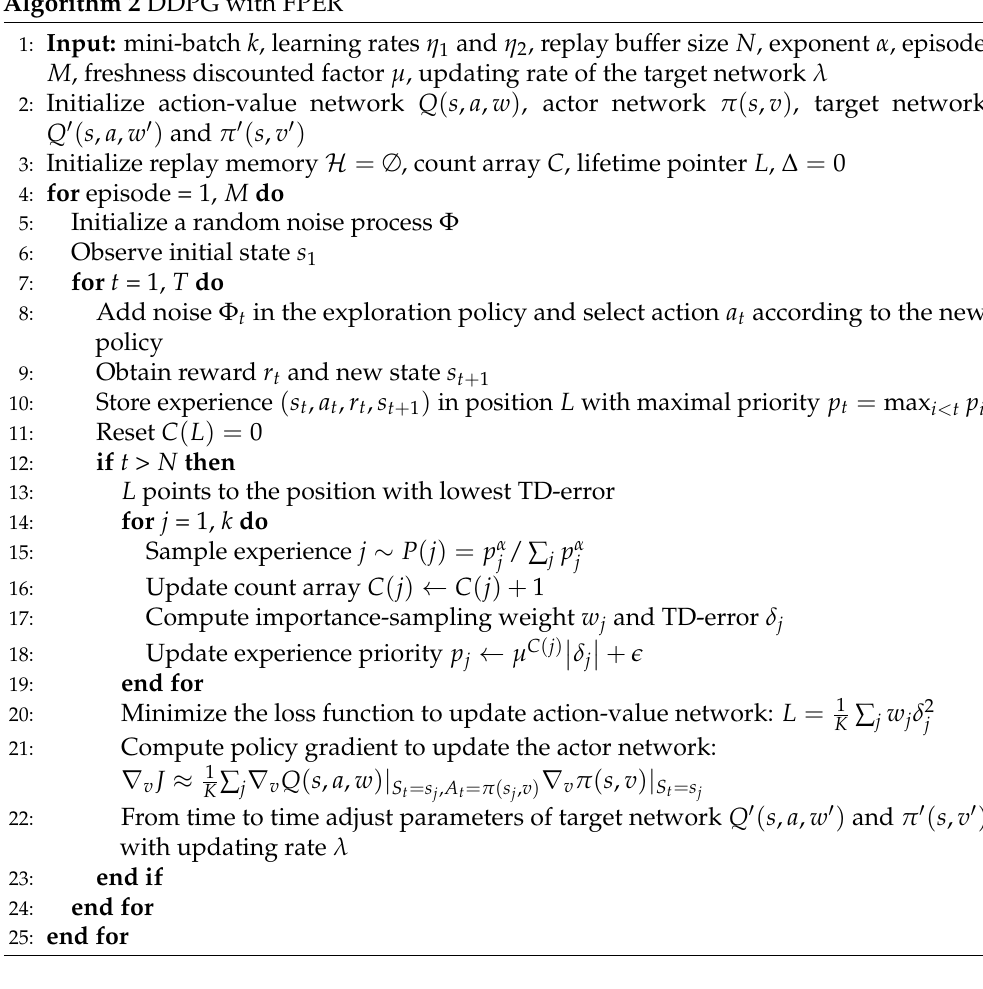
Algorithm 2 DDPG with FPER